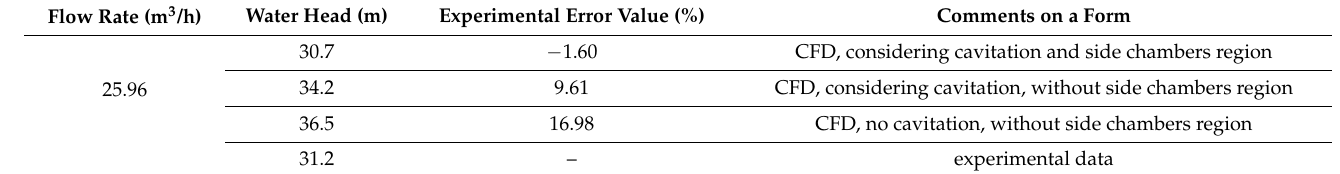
Table 3. Comparison of experimental data and simulated data under different